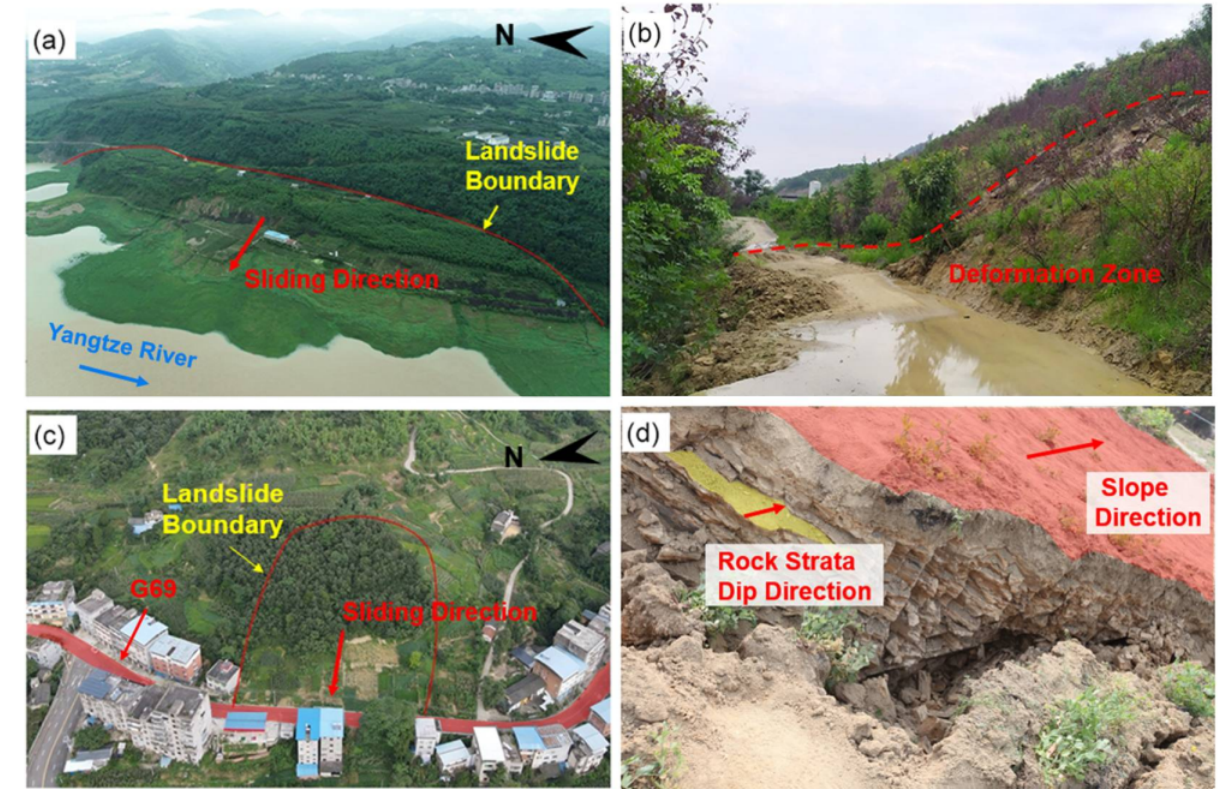
Figure 2. ( a ) Aerial view of the Jinjinzi landslide; ( b ) The active deformation zone of Jinjinzi landslide; ( c ) Aerial view of the Tongzilin landslide; ( d ) Observed tensile cracks on the right boundary of Tongzilin